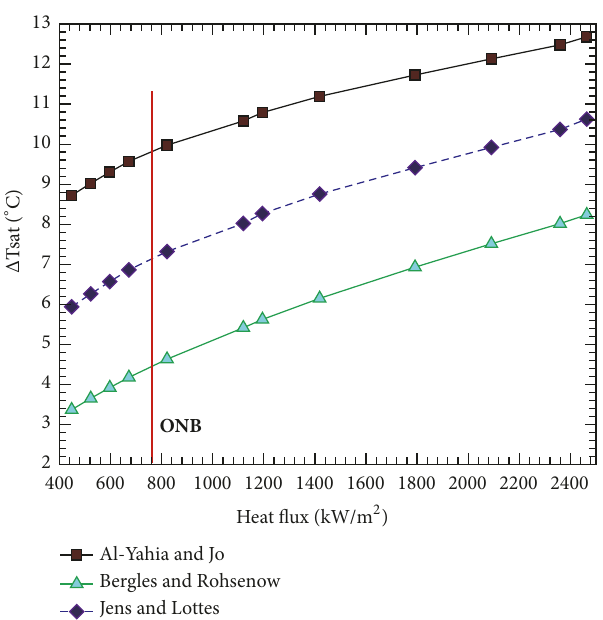
as shown in Figure 11. The slope of the wall temperature reduces around the ONB location as shown by the trend lines for low and high heat fluxes for the 3 correlations considered, Al-Yahia and Jo, Bergles and Rohsenaw, and Jens and Lottes. These correlations indicate that the onset of nucleate boiling occurs for heat fluxes just below 800 kW/m 2 . The wall superheat temperature varies between 3 ∘ C and 9 ∘ C. This point occurs at control volume number 5 at 250 mm from the subchannel